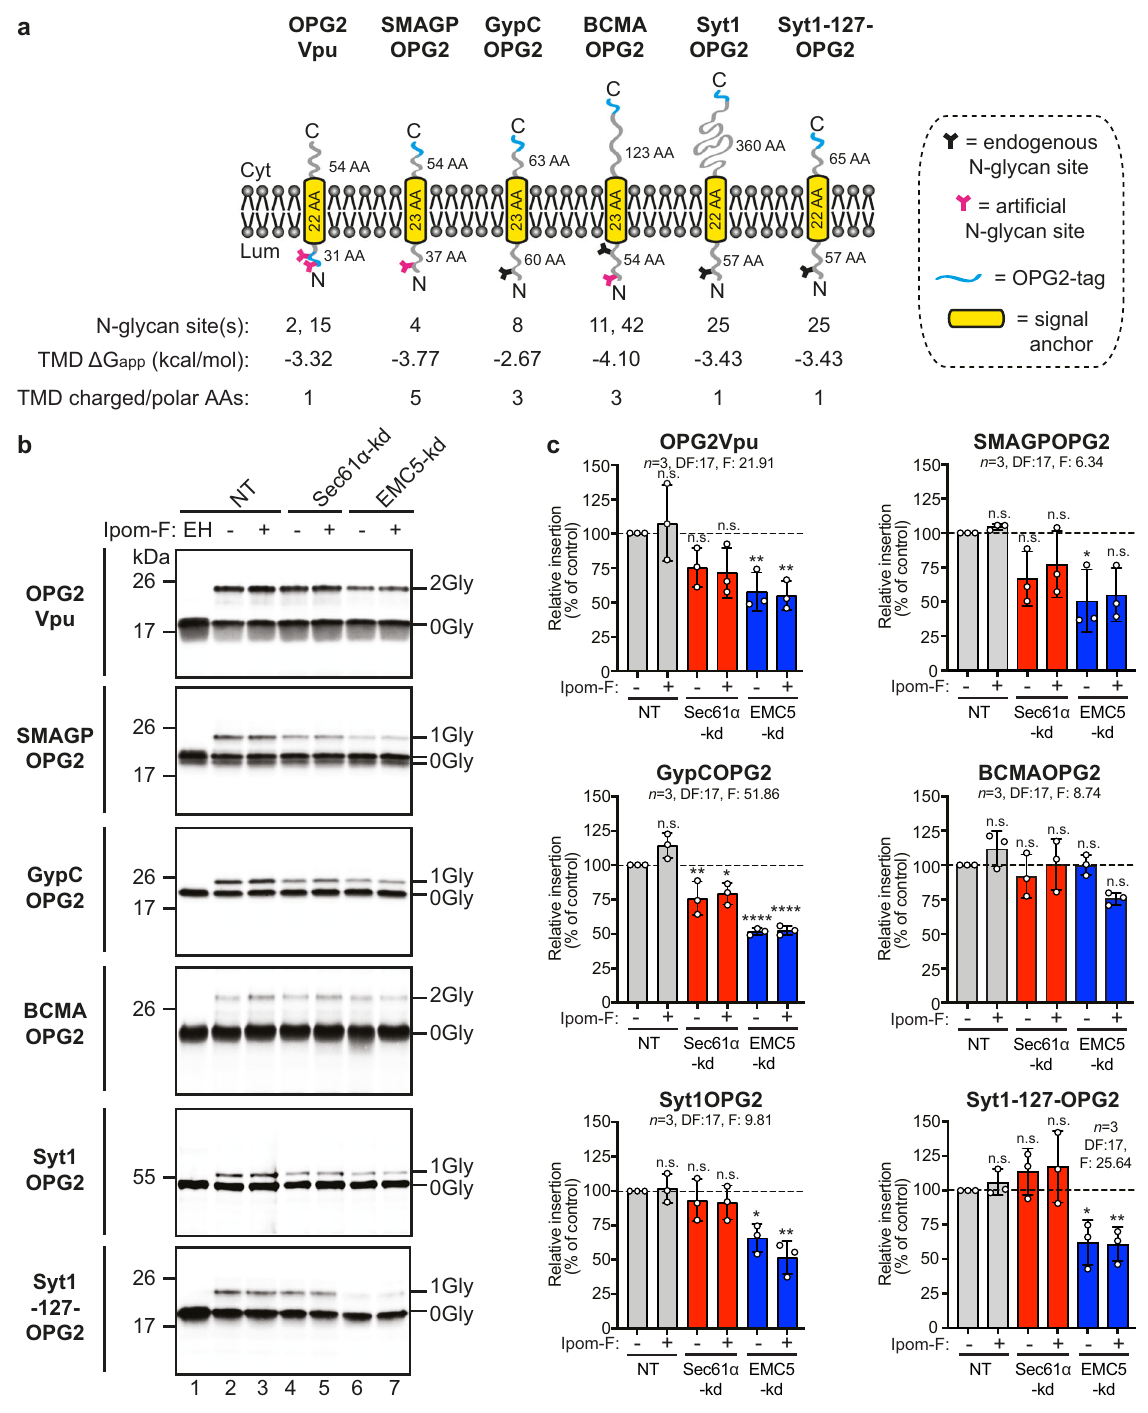
Fig. 4 Type III TMPs utilise the EMC for membrane integration. a Representative structures of type III TMPs (all OPG2-tagged as indicated) together with the biochemical properties of their transmembrane domains (TMDs). b Type III TMPs were synthesised using SP cells pre-treated with the indicated siRNA (NT, lanes 1 – 3; Sec61 α -targeting, lanes 4 – 5; EMC5-targeting, lanes 6 – 7), recovered and analysed as described in the legend to Fig. 4. c Quanti fi cation of type III TMP insertion for HIV protein Vpu (OPG2Vpu), small cell adhesion glycoprotein containing an arti fi cial N-glycan site (SMAGPOPG2), glycophorin C (GypCOPG2), tumour necrosis factor receptor superfamily member 17 containing an arti fi cial N-glycan site (BCMAOPG2), synaptotagmin 1 (Syt1OPG2) and a cytosolically truncated version of Syt1OPG2 (Syt1-127-OPG2). Estimated hydrophobicity values ( 4 Gapp) 42 and the number of charged/polar amino acid residues (AAs) in